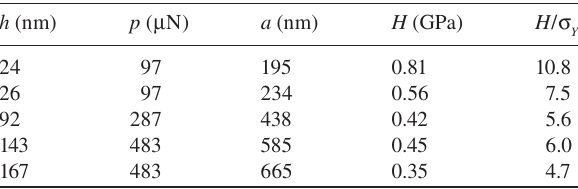
Table 2 Experimental measurements of hardness for Al in very small indentation depths [10] . For the determination of H / σ value of 75 MPa was used for σ